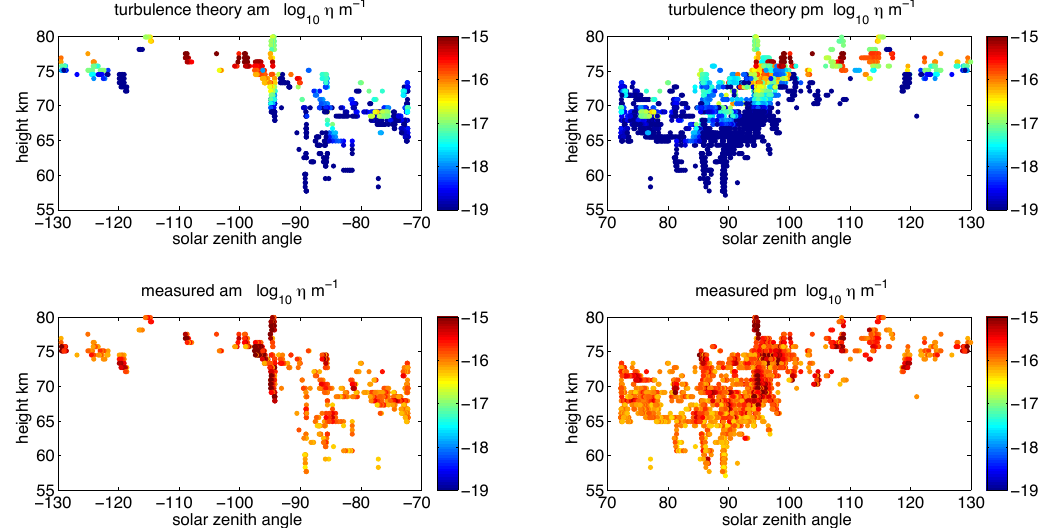
Figure 11. Theoretically expected and observed PMWE volume reflectivities as a function of solar zenith angle and height. Theoretical estimates are for turbulence due to wind shear assuming a turbulent energy dissipation rate of 100mWkg − 1 and buoyancy frequency of 0.02rads − 1